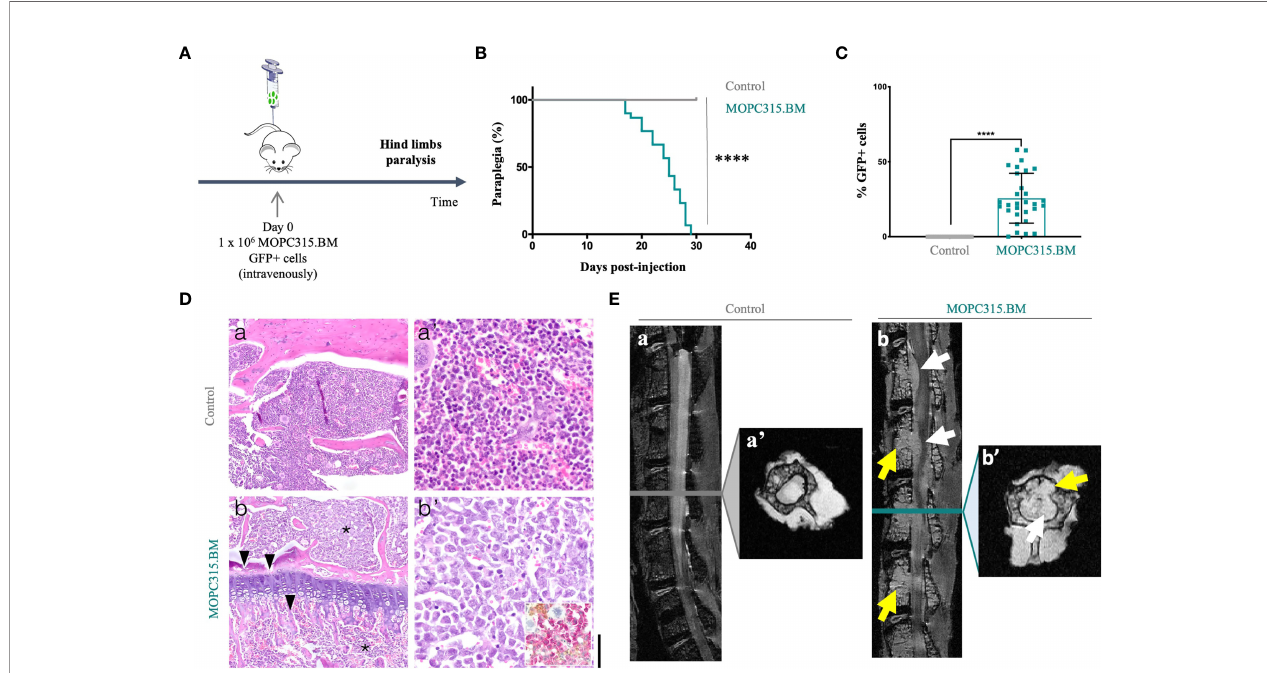
FIGURE 1 | MOPC315.BM cell characterization. (A) Schematic representation of the experimental timeline. (B) BALB/cByJ mice were injected intravenously with PBS (control; n = 20; gray line) or MOPC315.BM cells (n = 30; blue line). Time to paralysis was calculated through log-rank test evaluation (p < 0.0001). (C) Percentage of GFP + tumor-expressing cells from the BM of mice injected with PBS (control; n = 20; gray squares) and with MOPC315.BM cells (n = 30; blue squares). Statistical analysis was performed using the non-parametric Mann – Whitney test (p < 0.0001). (D) Representative histopathological analysis of BM of BALB/cByJ mice; a-a ’ , control animals show normocellular BM with normal hematopoiesis; b-b ’ , MOPC315.BM-bearing mice show a hypercellular BM with almost complete replacement of the hematopoietic tissue by a dense monomorphous blast-like round cell population (asterisk), with numerous mitotic fi gures, large cleaved eccentric nucleus, and with rare giant cells. The myeloma cells are CD138 positive (inset), associated with osteolysis (arrowhead); a, b, original magni fi cation 10× (bar, 150 m m). a ’ , b ’ , original magni fi cation 40× (bar, 40 m m). Hematoxylin and eosin; inset, immunohistochemistry for CD56 (DAB; brown) and CD138 (AEC; pink) counterstained with Harris hematoxylin. (E) High-resolution magnetic resonance imaging in control (n = 2) versus MOPC315.BM-bearing mice (n = 2). Sagittal fat-suppressed T2-weighted images — a, b; corresponding axial T2*- weighted images through selected vertebral bodies — a ’ , b ’ . Representative image reveals extensive BM in fi ltration in mice with established disease (b and b ’ , yellow arrows). The tumors disrupt the posterior wall of the vertebral bodies and extend to the spinal canal, causing compression of the spinal cord and involving the nerve roots (b and b ’ , white arrows). p -values are shown as ****p ≤